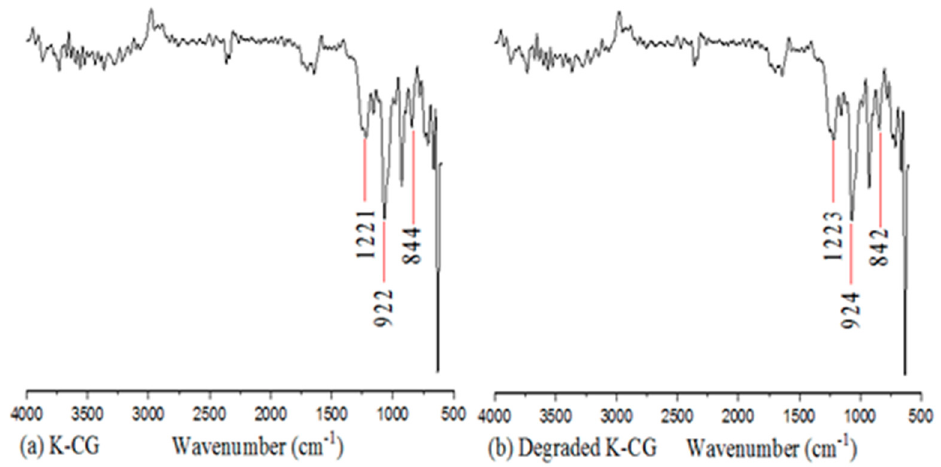
Figure 1. The infrared spectra of samples of K_CG ( a ) and after degraded K_CG ( b ).